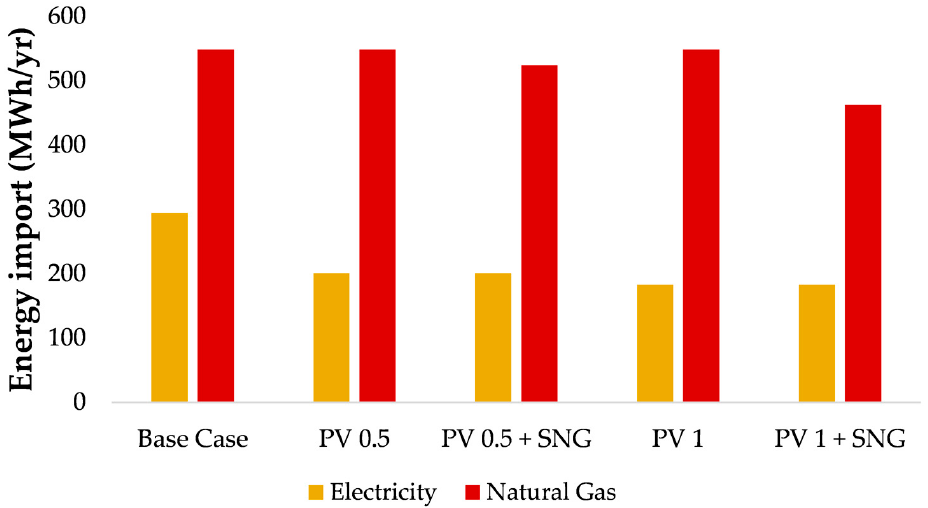
Figure 9. Electricity and Natural Gas import in the five scenarios.